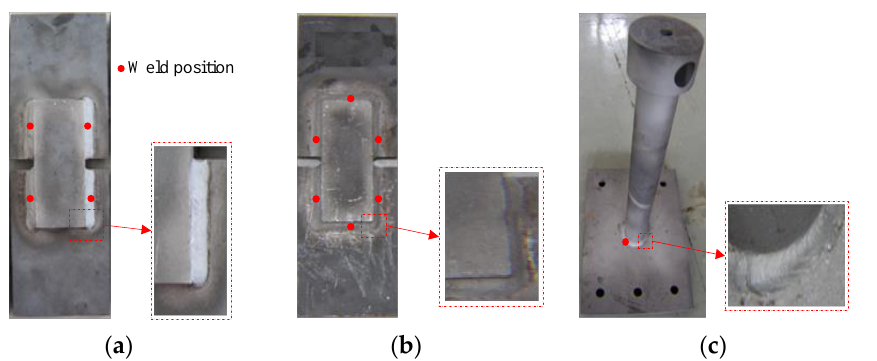
Figure 10. Typical welded specimens of the frame: ( a ) standard shear; ( b ) U-shaped fillet welded; ( c ) pipe-plate fillet welded.